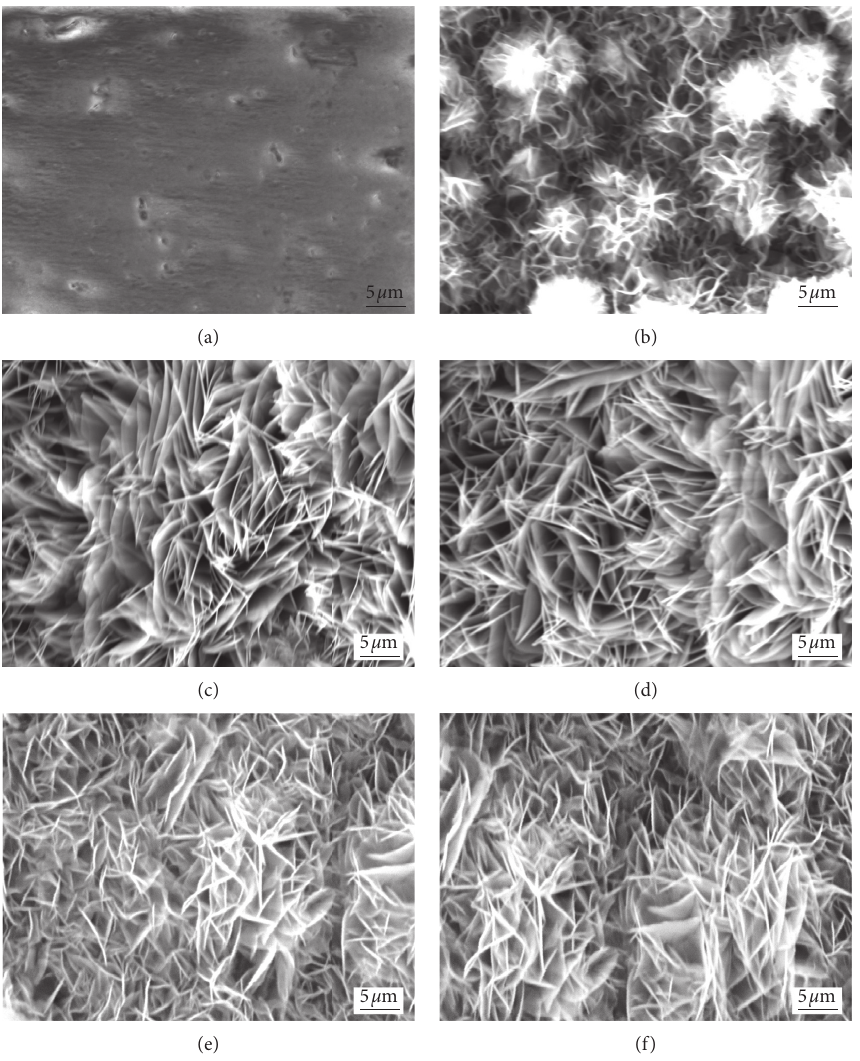
Figure 3: SEM images of LDHs: (a) anodized surface, (b) LDH on bare AA6082 surface, (c) LDH, (d) LDH-H, (e) CeLDH, and (f)